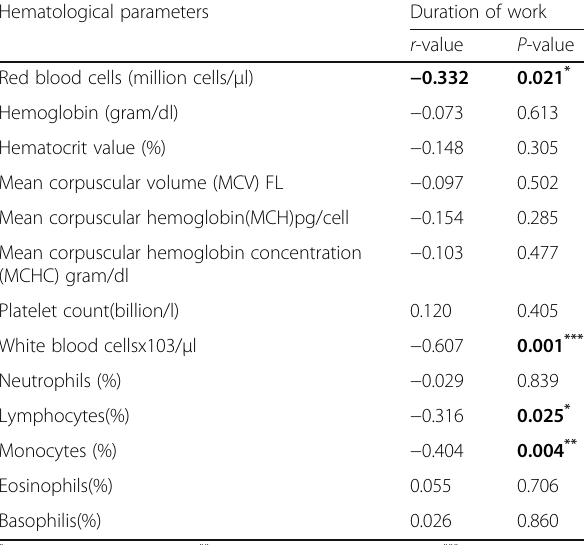
Fig. 1 Correlation between duration of work and